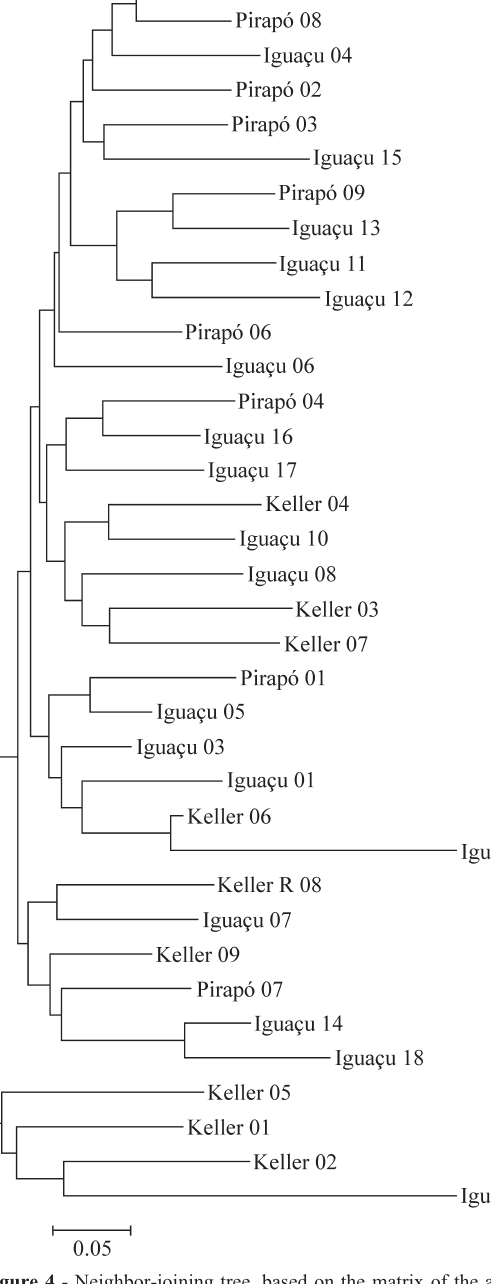
Figure 4 - Neighbor-joining tree, based on the matrix of the arithmetic complement of the similarity coefficient of Nei and Li (1979), obtained from RAPD markers of Astyanax altiparanae individuals from the Iguaçu River, and from the Keller and Pirapó tributaries of the Upper Paraná River